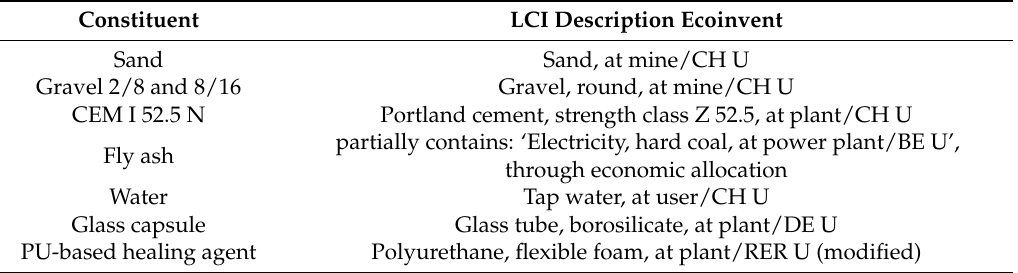
Table 4. Overview of the Ecoinvent life cycle inventory (LCI) data